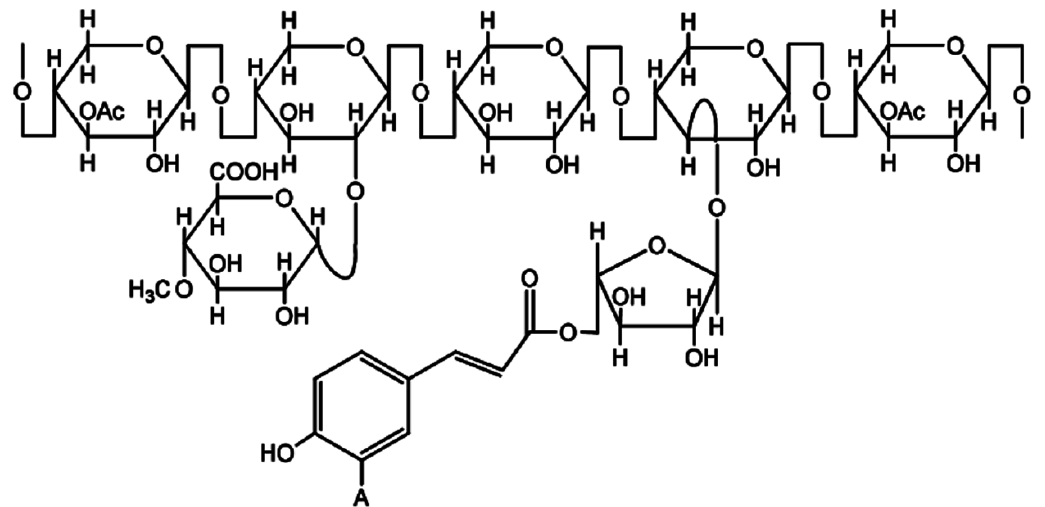
Figure 2. Representative hemicellulose structure (Reprinted with permission from [45]. Copyright 2014, Elsevier).